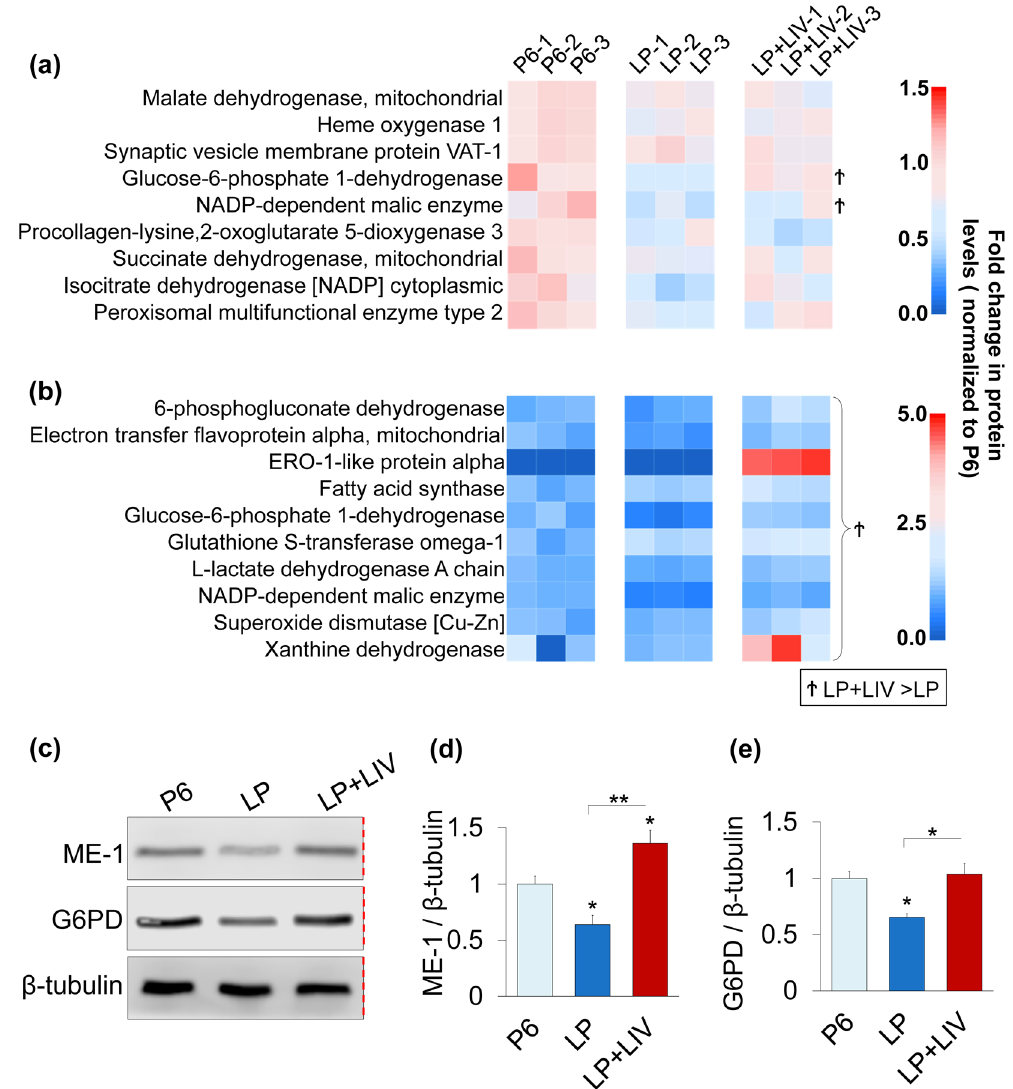
Figure 9. Prolonged culture but not LIV decreases proteins associated with oxidoreductase activity. ( a ) In vitro expansion of MSCs significantly decreased nine proteins related to oxidoreductase activity in LP cells (p < 0.05). G6PD and ME-1 were significantly upregulated in LP + LIV compared to LP ( Ϯ p < 0.05) ( b ) Ten proteins associated with oxidoreductase activity exhibited significantly higher levels in the LP + LIV group compared to LP (p < 0.05) but were not changed compared to P6. Further, xanthine dehydrogenase and ERO1-like protein alpha were significantly elevated in the LP + LIV group when compared to the P6 group (p < 0.05). Identified differences (p < 0.05) between LP and LP + LIV were further denoted as Ϯ : LP + LIV > LP. ( c ) Representative western blots using primary antibodies against ME-1, G6PD and β -tubulin. Red dashed line indicates a cropped blot, full- length blots are presented in Supplementary Fig.S2. Samples derive from the same experiment and that blots were processed in parallel. ( d ) All measurements were normalized to P6 (i.e P6 was set to 1). Protein levels in the LP group was 0.63, a 37% decrease compared to the P6 group (p < 0.05). Average ME-1 protein level of the LP + LIV group was 1.36, a 36% (p < 0.05) and a 215% (p < 0.01) increase compared to the P6 and the LP groups. ( e ) Total G6PD protein level of the LP group was 0.65, remaining 35% lower compared to P6 (p < 0.05). G6PD levels of the LP + LIV group was back to 1.03 and was not significantly different than the P6 group, while remaining 58% larger than the LP group (p < 0.05). n = 3/grp. Group comparisons were made using one-way ANOVA followed by